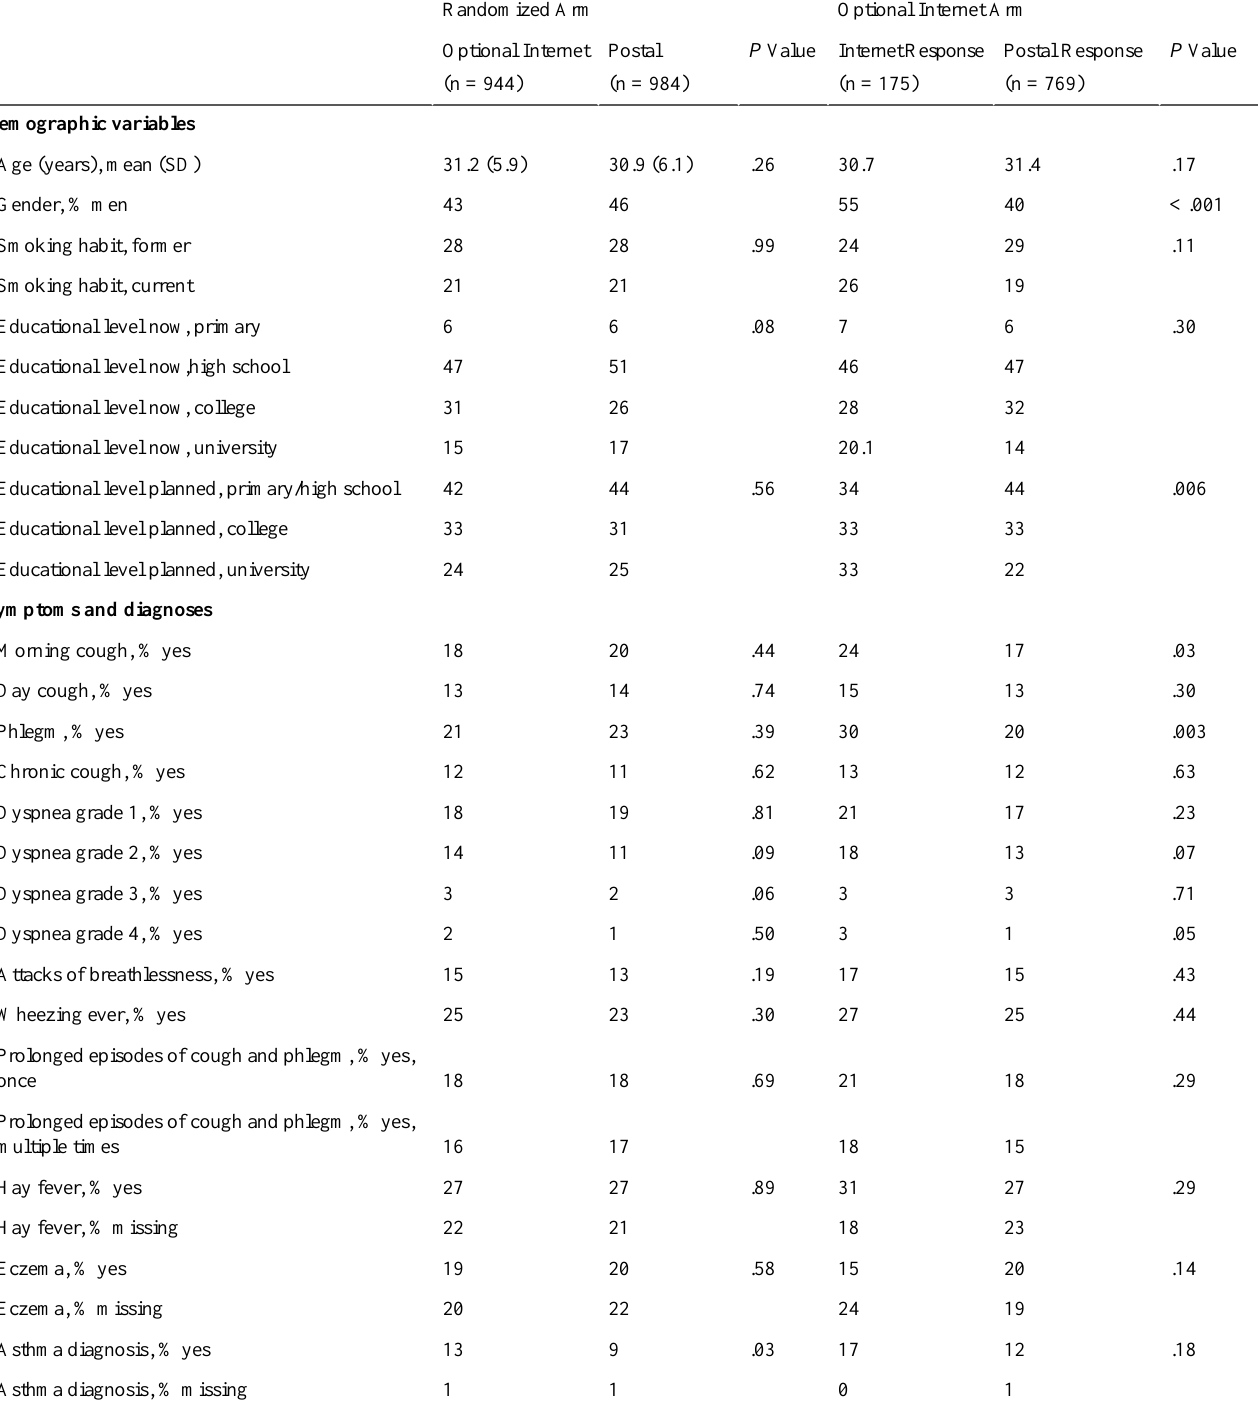
Table 4. Main survey results (demographics, prevalence of symptoms, and diagnoses), according to randomization and chosen response mode in the optional Internet response